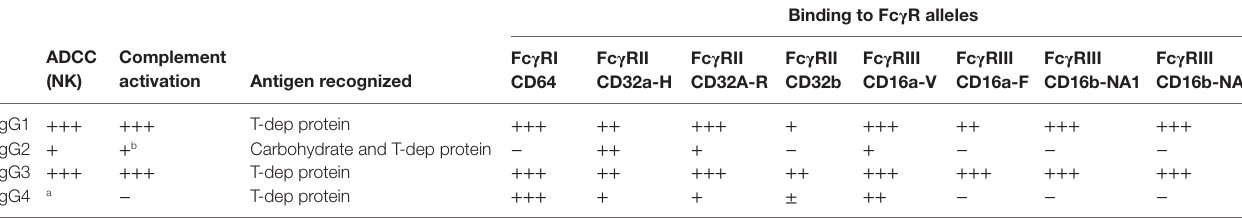
TABLe 1 | Summary of igG subclass effector functions.